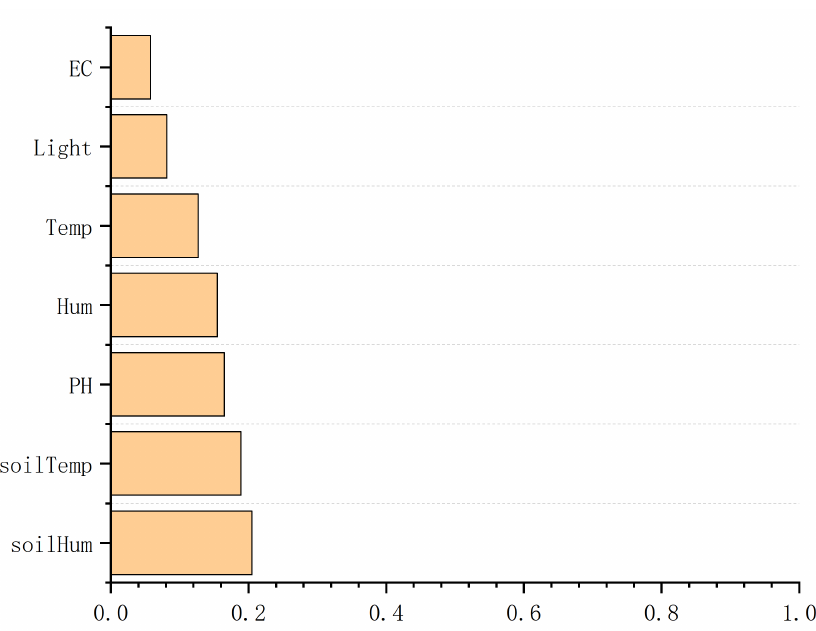
Figure 5. Analysis chart of the importance of environmental